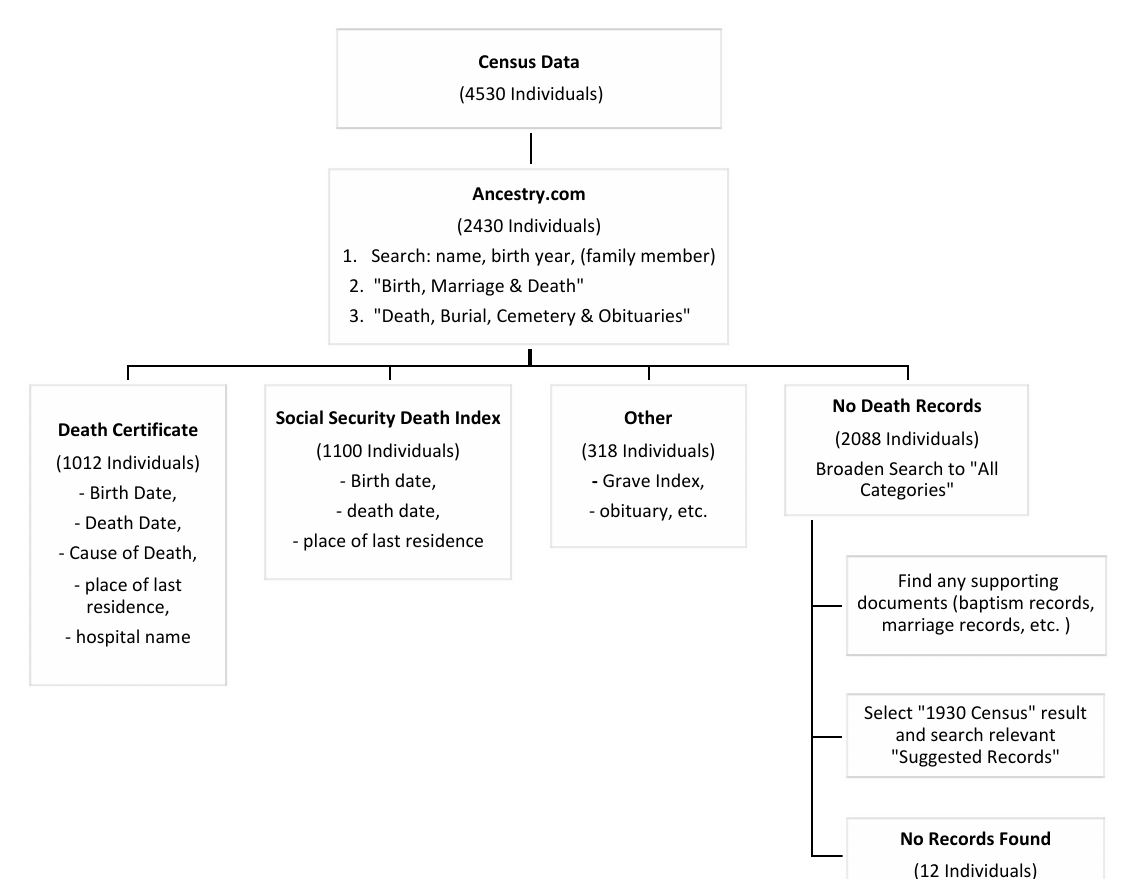
Figure 3. Decision tree for Ancestry.com derived mortality information.